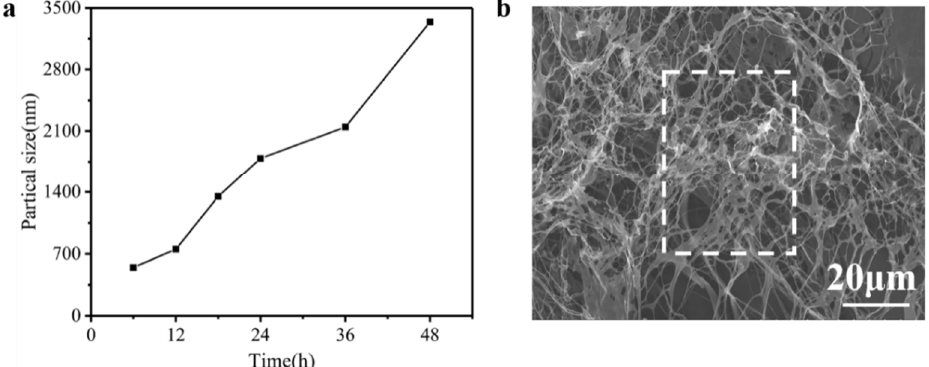
Figure 3. ( a ) The changes in particle size of type I collagen from 6 h to 48 h. ( b ) SEM analysis at 48 h (×1000).